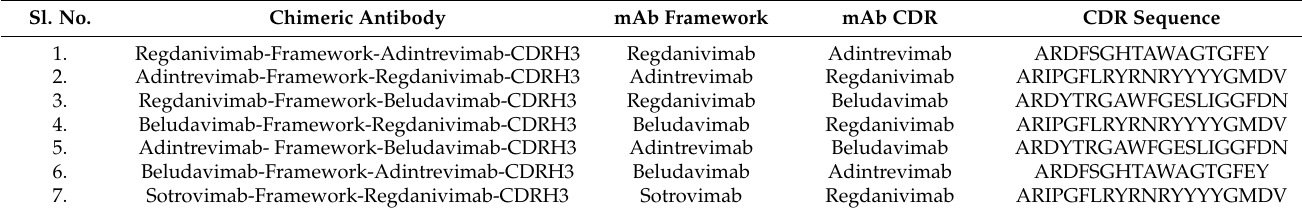
Table 3. List of chimeric mAbs * conceived by using the selected high affinity mAbs. Sl. No.